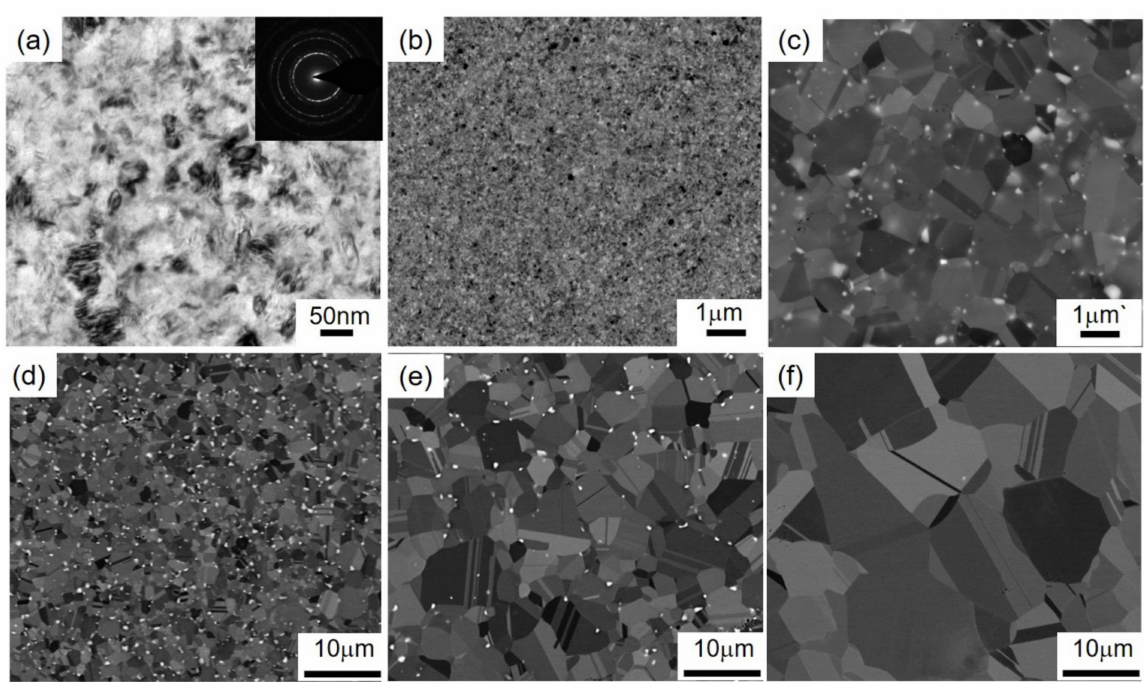
Figure 2. Microstructure of HPT-produced 316LN steels annealed at different temperatures: ( a ) HPT-5N; ( b ) 700 ◦ C annealing; ( c ) 750 ◦ C annealing; ( d ) 800 ◦ C annealing; ( e ) 850 ◦ C anneal- ing; ( f ) 900 ◦ C